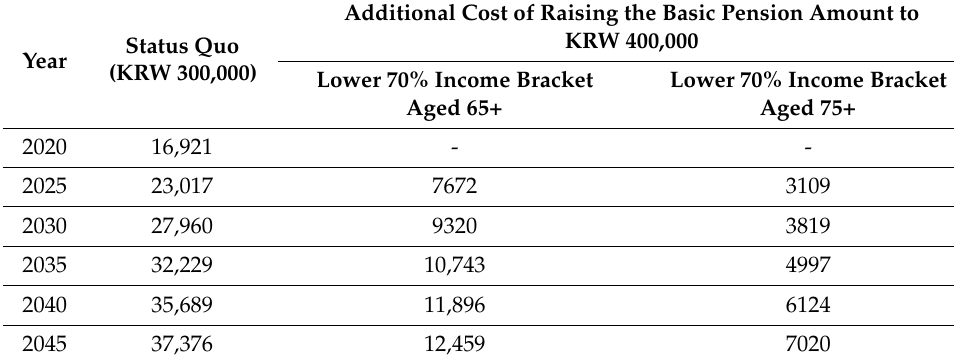
Table 6. Estimated additional cost of raising the basic pension amount. Unit. 10 billion